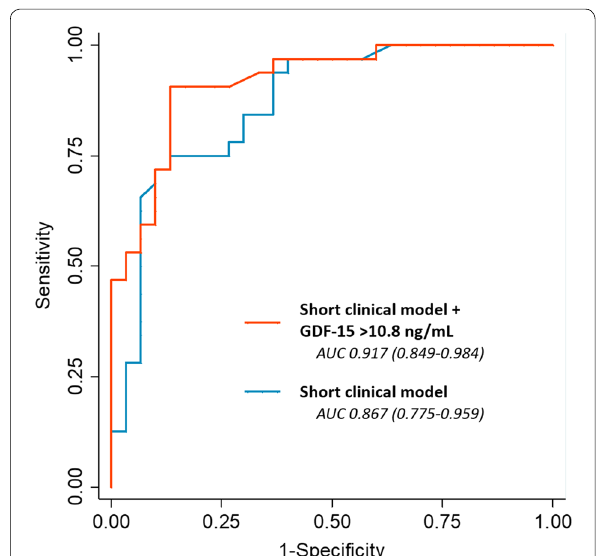
Fig. 3 ROC curves showing the accuracy of GDF‑15 for predicting poor neurologic outcome at 6 months, when added in a dichotomous manner ( 10.8 ng/mL) to the short clinical ≥